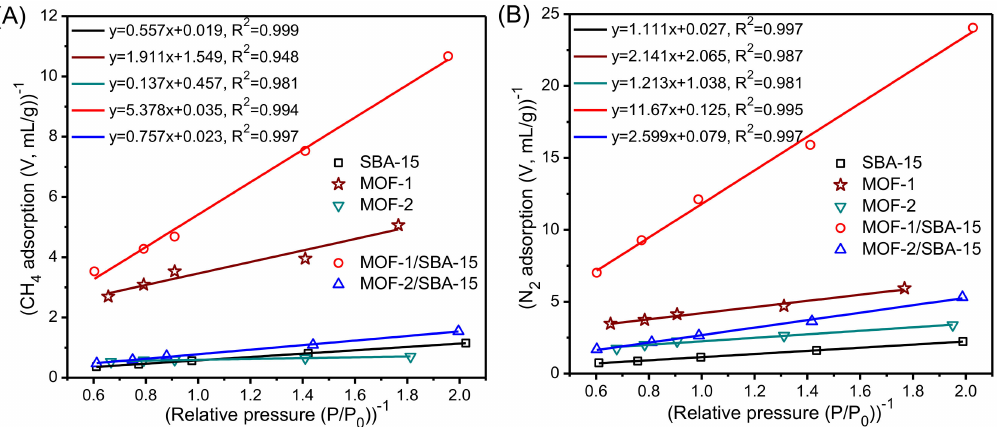
Figure 7. (1/ V ) versus (1/ P ) plots of CH 4 ( A ) and N 2 ( B ) for the samples. Symbols: experimental values; —— linear fitting to the Langmuir equation.